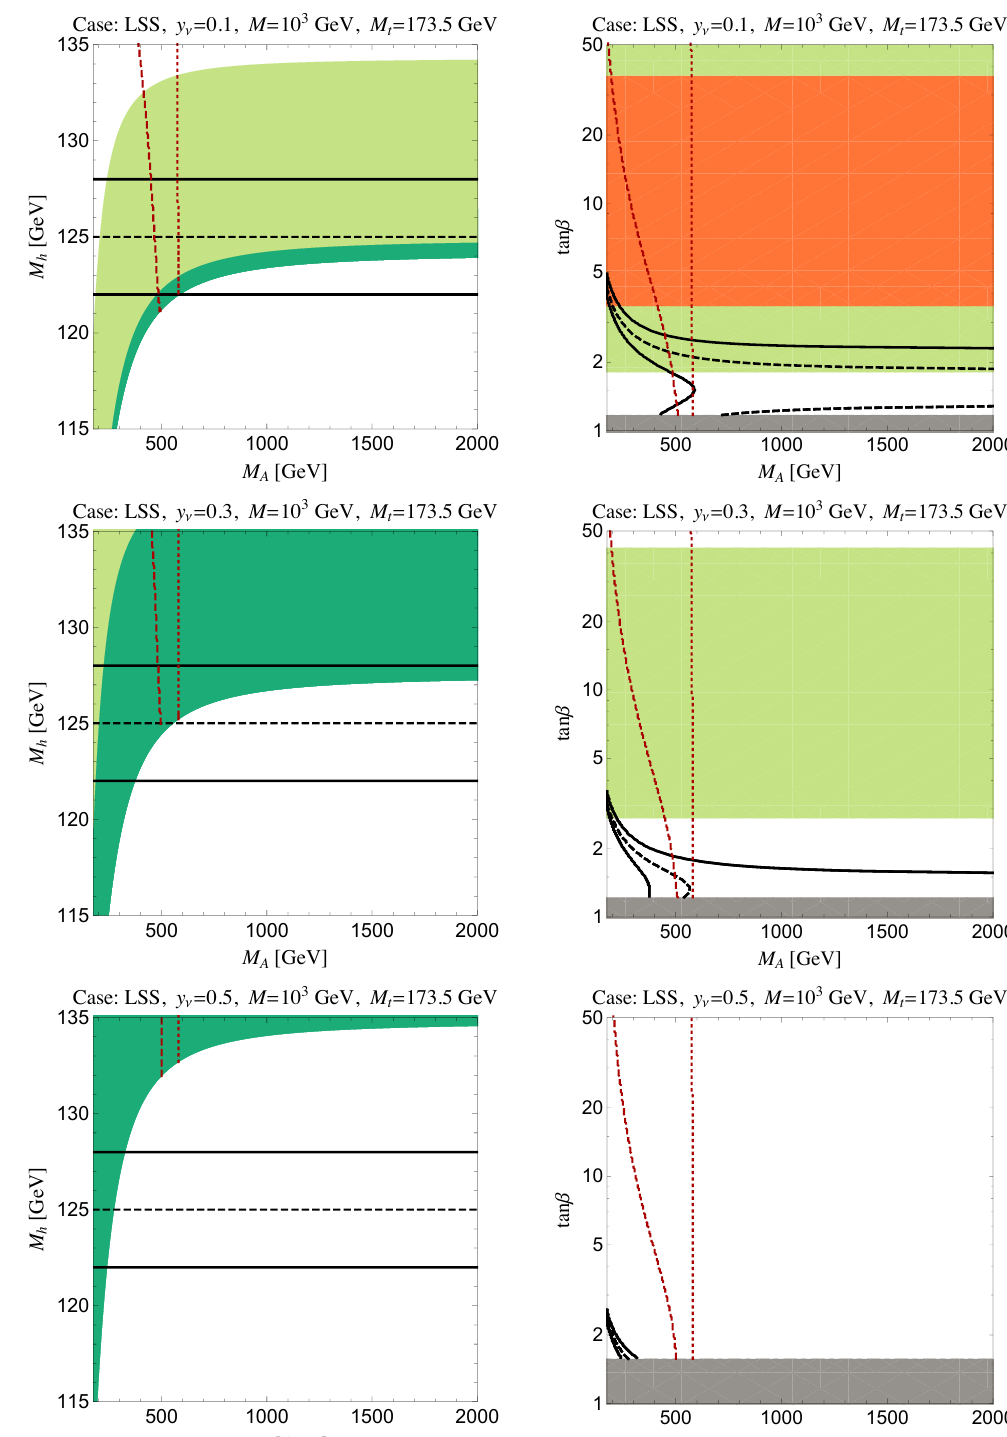
Figure 6 . The details are same as given in the caption of (cid:12)gure 1.